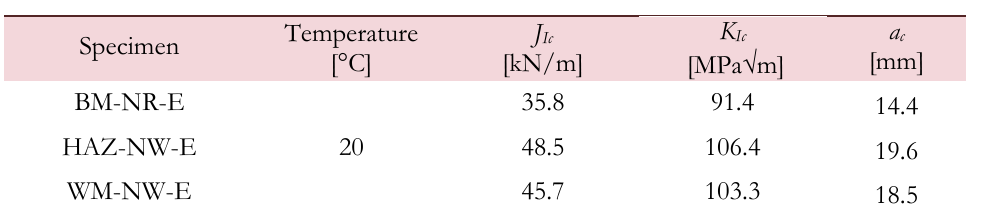
Table 1: The values of J Ic K Ic and a c - pipe taken from service.